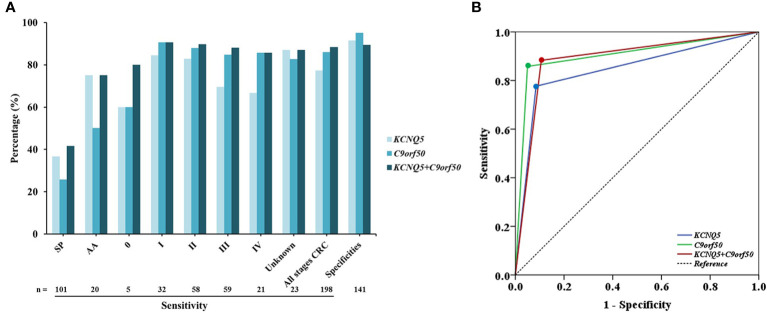
Sensitivities and specificities of methylated KCNQ5 and methylated C9orf50 in stool DNA for small polyp (SP), advanced adenoma (AA), and colorectal cancer (CRC) detection (A), and the receiver operating characteristic (ROC) curves of methylated KCNQ5 and methylated C9orf50 in stool DNA for CRC detection (B).